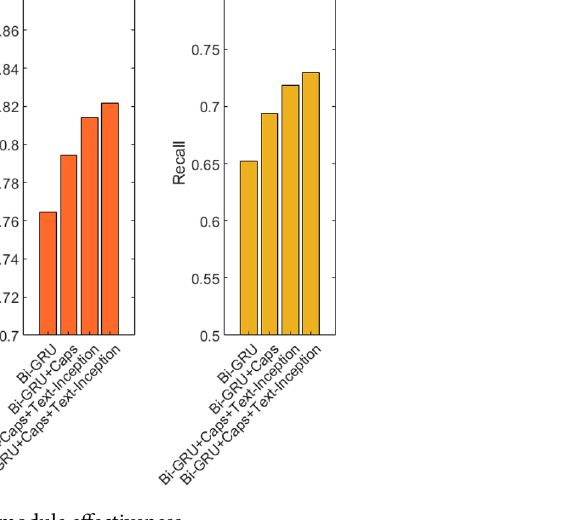
Figure 6. Visual results of module effectiveness.